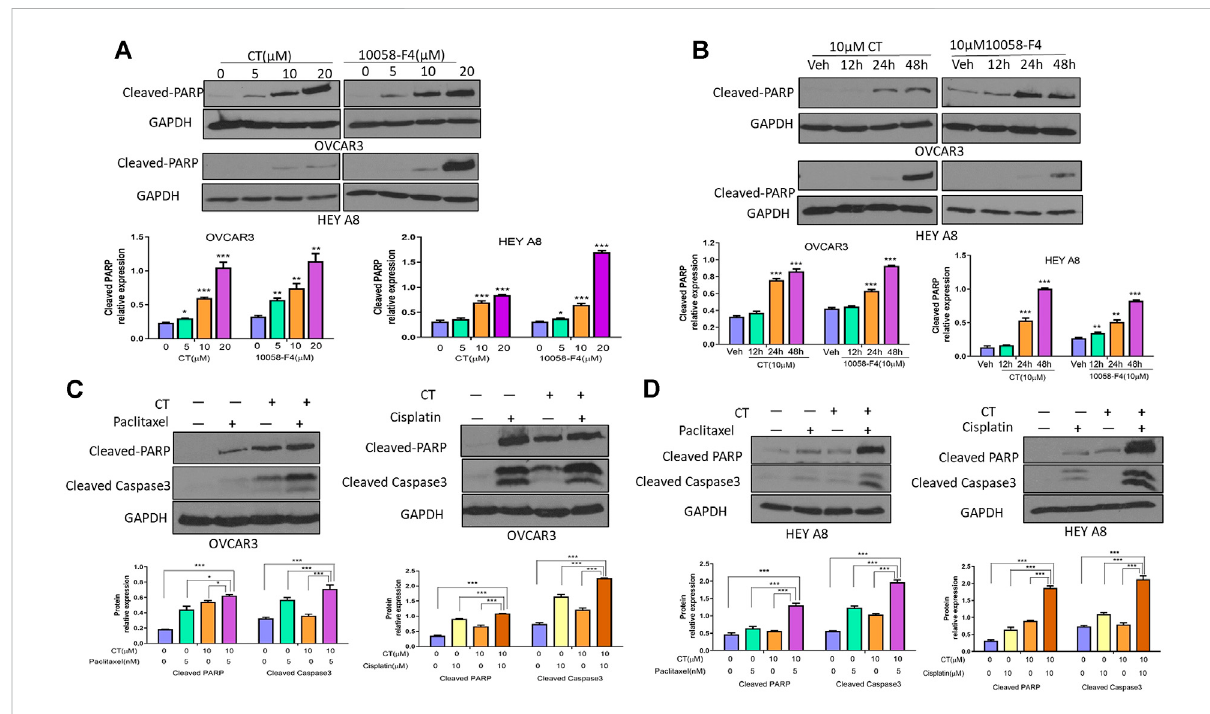
FIGURE 5 CT sensitizes chemotherapy drug induced apoptosis in ovarian cancer cells. (A,B) Immunoblot and densitometry analysis of apoptosis in OVCAR3andHEYA8cellsbyexaminingcleaved-PARPaftertreatmentwith (A) differentdosesofCTor10058-F4for24 hor (B) thesamedoseofCT or 10058-F4 (10 µM) at different time points. (C,D) Immunoblot and densitometry analysis of apoptosis in OVCAR3 (C) and HEY A8 (D) cells by detection of cleaved-PARP and cleaved-caspase3 after 24 h treatment with CT alone or together with paclitaxel and cisplatin. One representative immunoblot from three similar independent experiments is shown. The expression of cleaved-PARP and cleaved-caspase3 were compared between cells treated with CT, 10058-F4, or vehicle. Data are presented as mean values ±SD. * p < 0.05, ** p < 0.01, *** p <